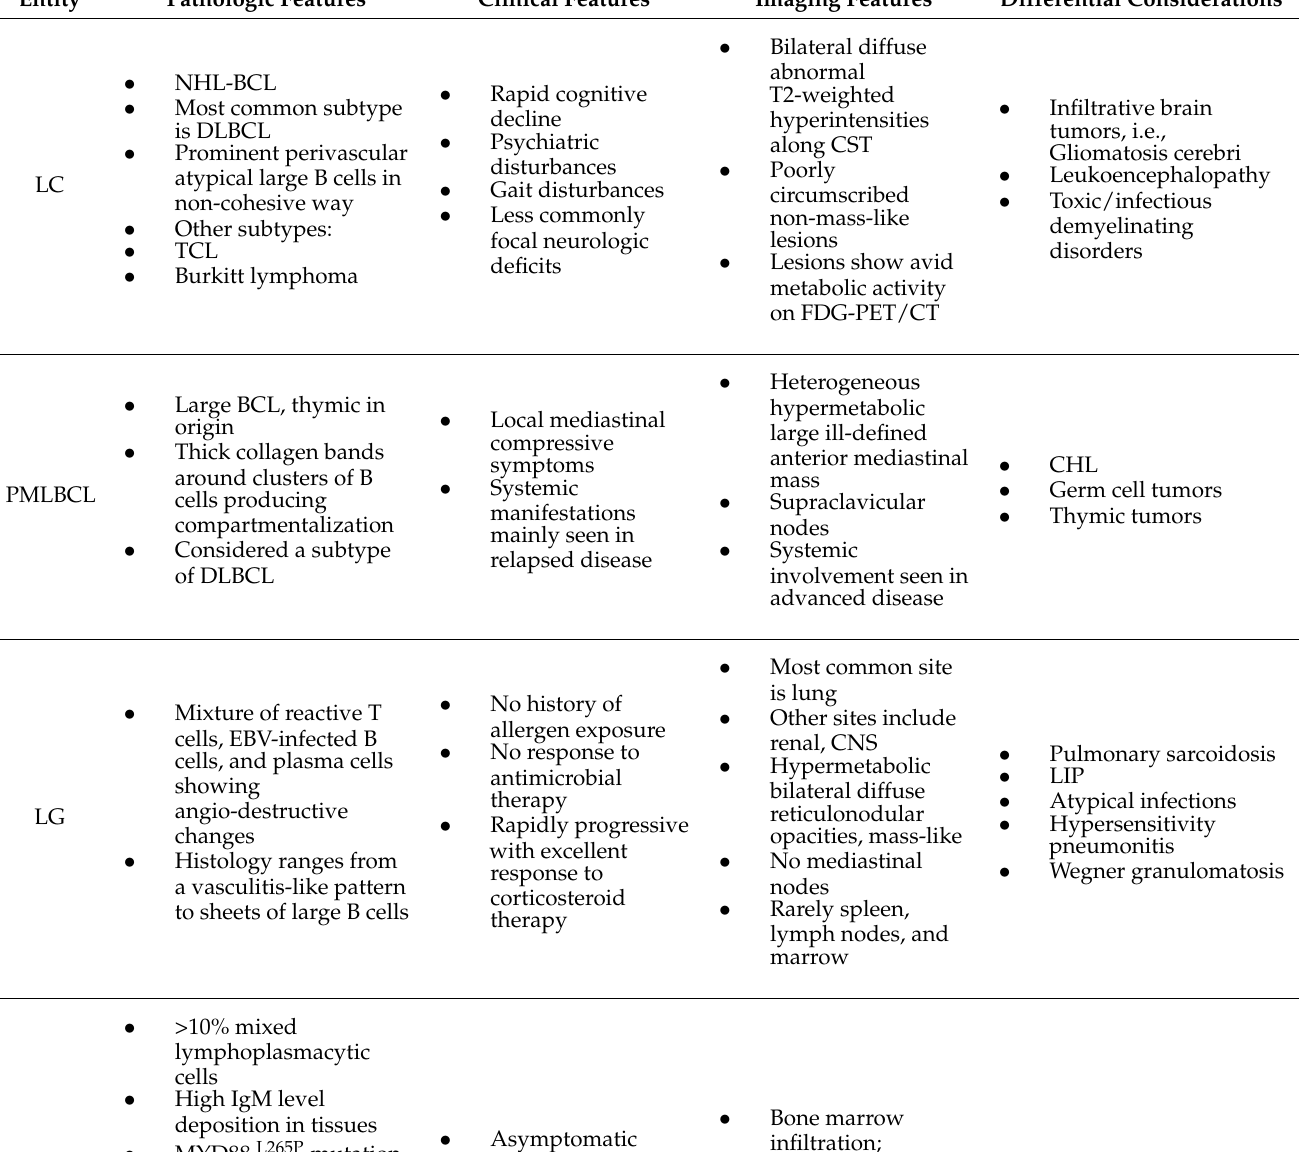
Table 2. Key pathologic, clinical, imaging features and differential diagnosis of rare B-cell lymphoma variants. Entity